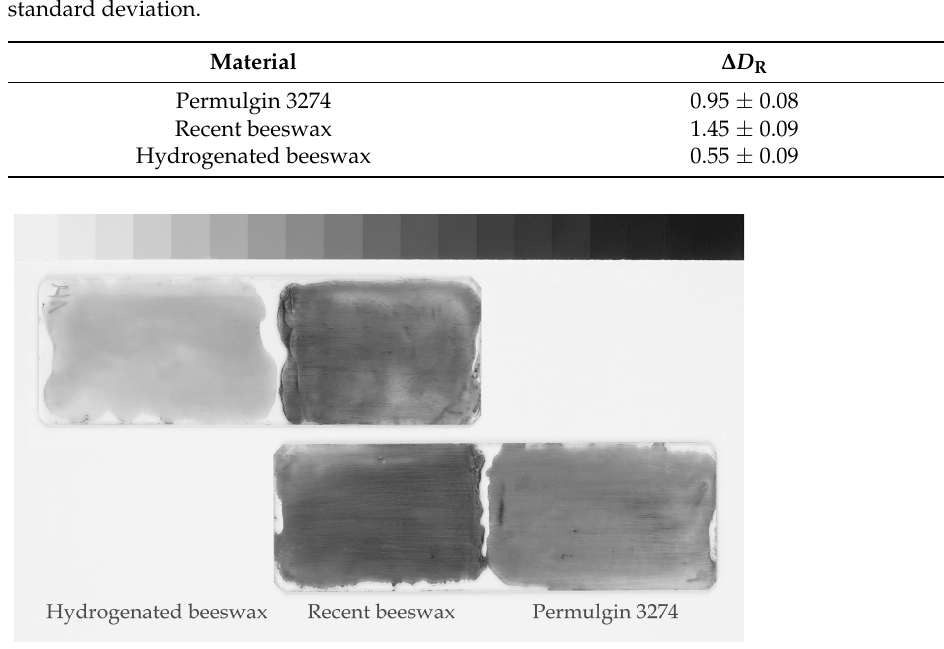
Figure 8 Figure 8. Incrustation of impurities into the surface of wax